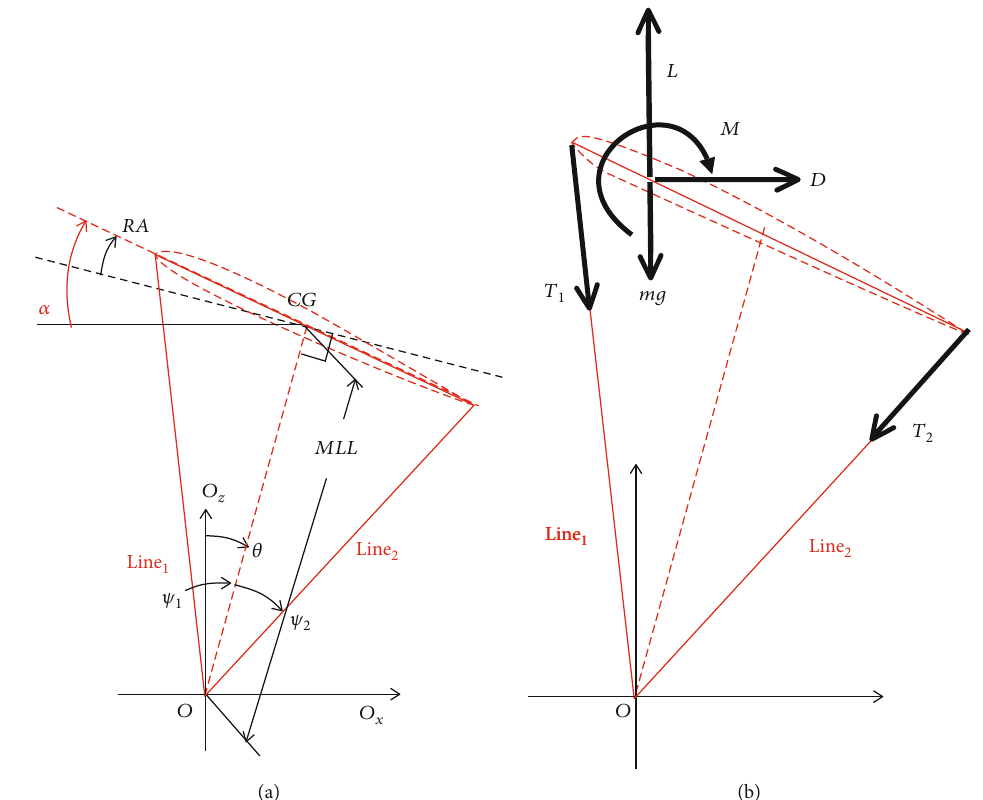
Figure 3: Schematic of the analytical model. (a) De fi nition of analysis parameters. (b) De fi nition of acting force and